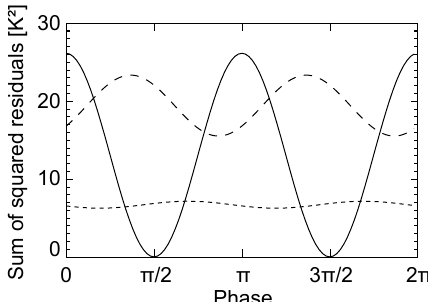
Figure 2. This figure shows the approximation of a cubic spline using different numbers of spline sampling points. (a) A spline with a distance of 1.5km between two spline sampling points is fitted (solid line) to the test data (dotted line). (b) Same as (a) but the distance between two spline sampling points is 1.6km. (c) Same as (a) but the distance between two spline sampling points is 1.4km. (d) Same as (a) but restricted to the height range between 15 and 50km. The dashed–dotted lines refer to the height-coordinate of the spline sampling points. The asterisks show the sampling points of to the original sine. (e) Same as (b) but restricted to the height range between 15 and 50km. (f) Same as (c) but restricted to the height range between 15 and 50km.